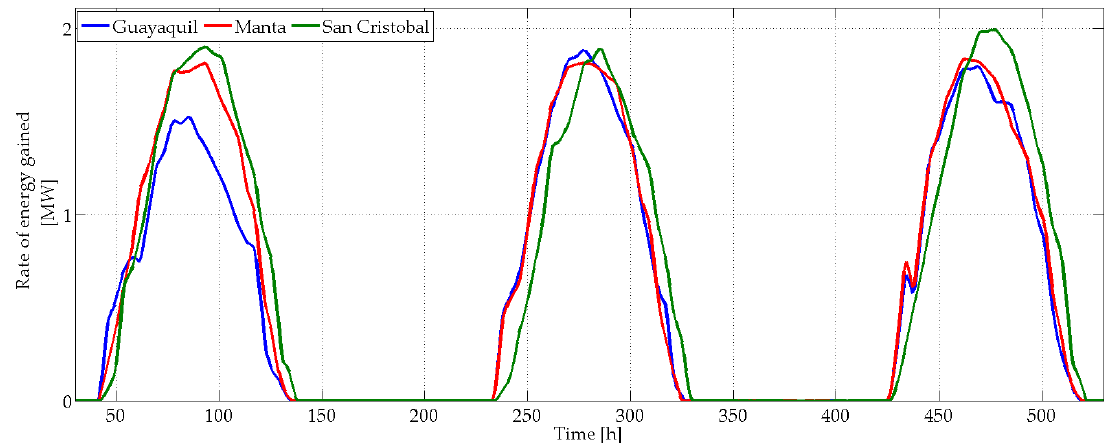
Figure 12. The collector thermal power gained for the selected sites of Ecuador.